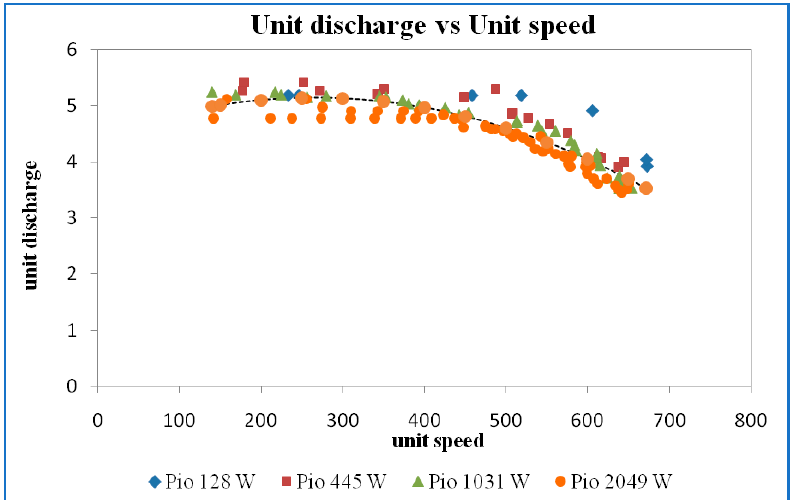
Figure 25. Unit discharge vs. unit speed at a guide vane opening of 10 mm. The variation of output power versus unit speed operating at different power inputs is shown in Figure 26. These points form a second-order polynomial curve fit with correlation coefficients near one. The maximum unit output power is found at a unit speed of 396 rpm.